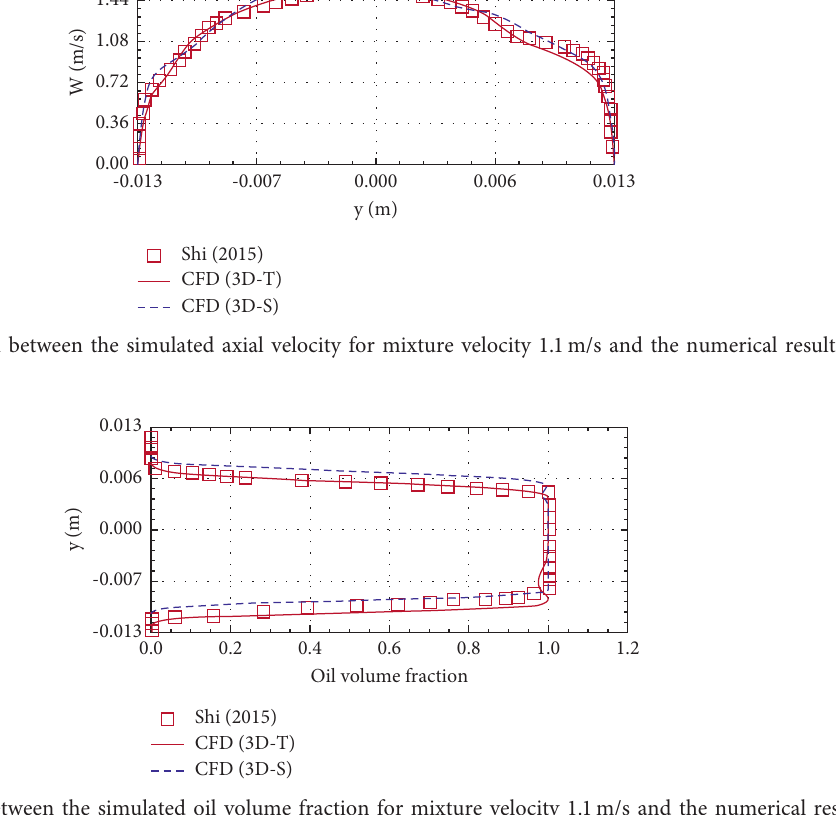
deformation of the axial velocity around the upper pipe wall is well reproduced. This deformation leads to a nonsym- metric character of these profiles and varies with the vari- ation of the two-phase interface. For the 3D-T configuration, the computed maximum � 1 . 56 m/s which is close to the Shi axial velocity is W max